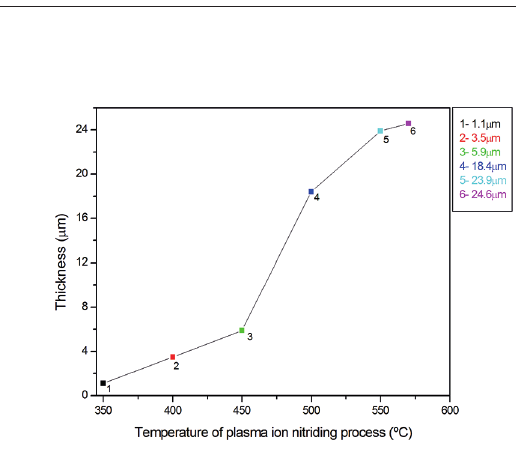
Figure 11: Thickness of the nitrided layer as a function of the treatment